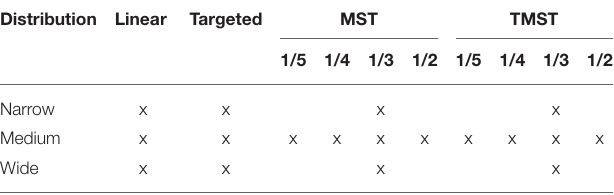
TABLE 3 | Overview of the 18 simulation conditions. Distribution Linear